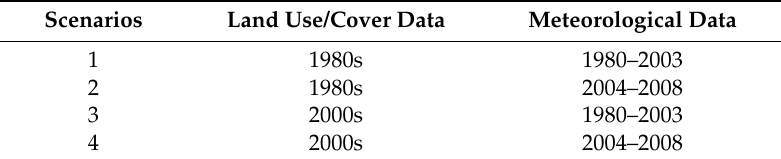
Table 4. Scenarios for quantitative attribution